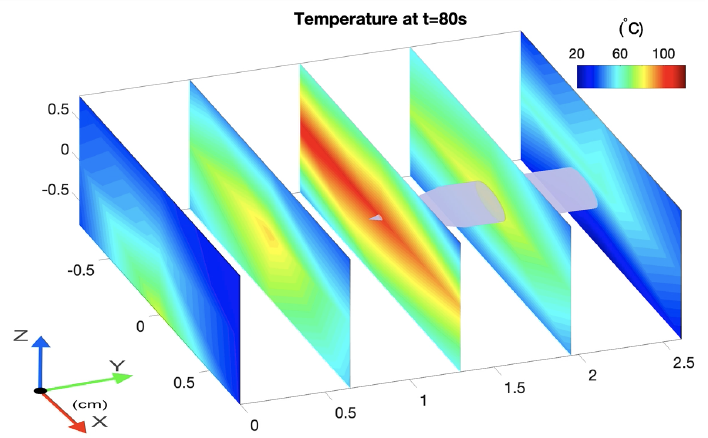
Figure 4. Temperature maps for the 1–8 fibers located furthest from the applicator.